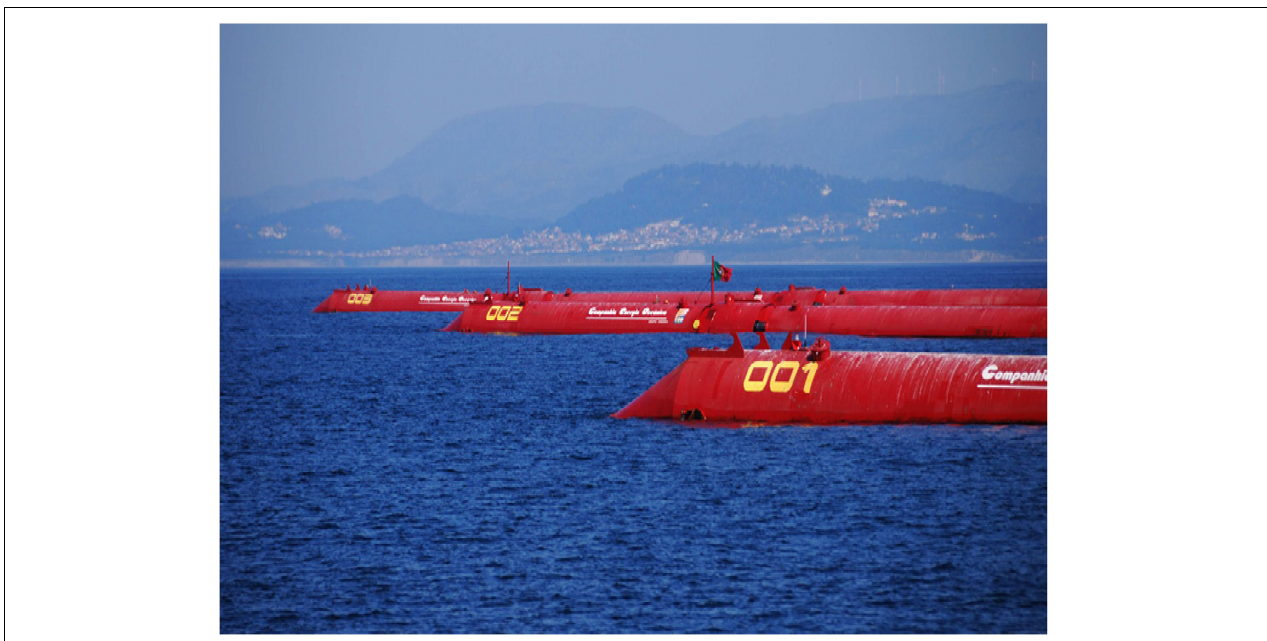
FIGURE 5 | Pelamis wave farm (Falcão, 2010).